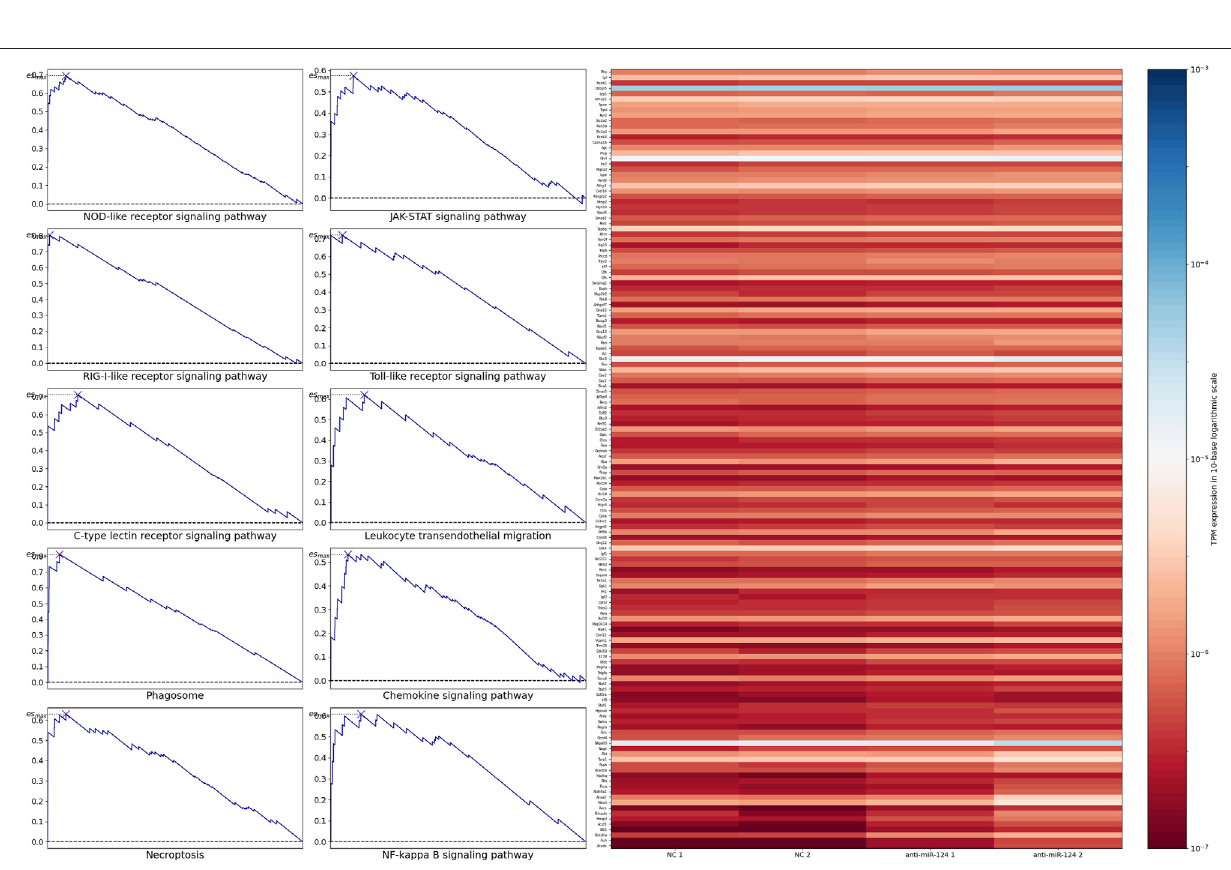
Frontiers in Genetics |